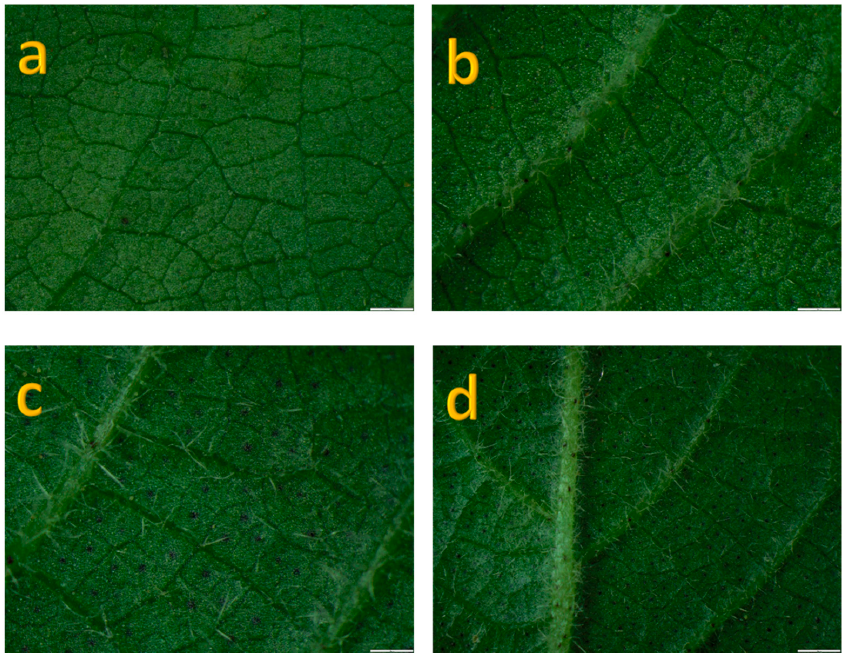
Figure 1. Microscopic images of leaf trichomes. A = no hairs, b = medium hairs, c and d = profuse hairy. Scale bars in (a–d) = 200 μ m.